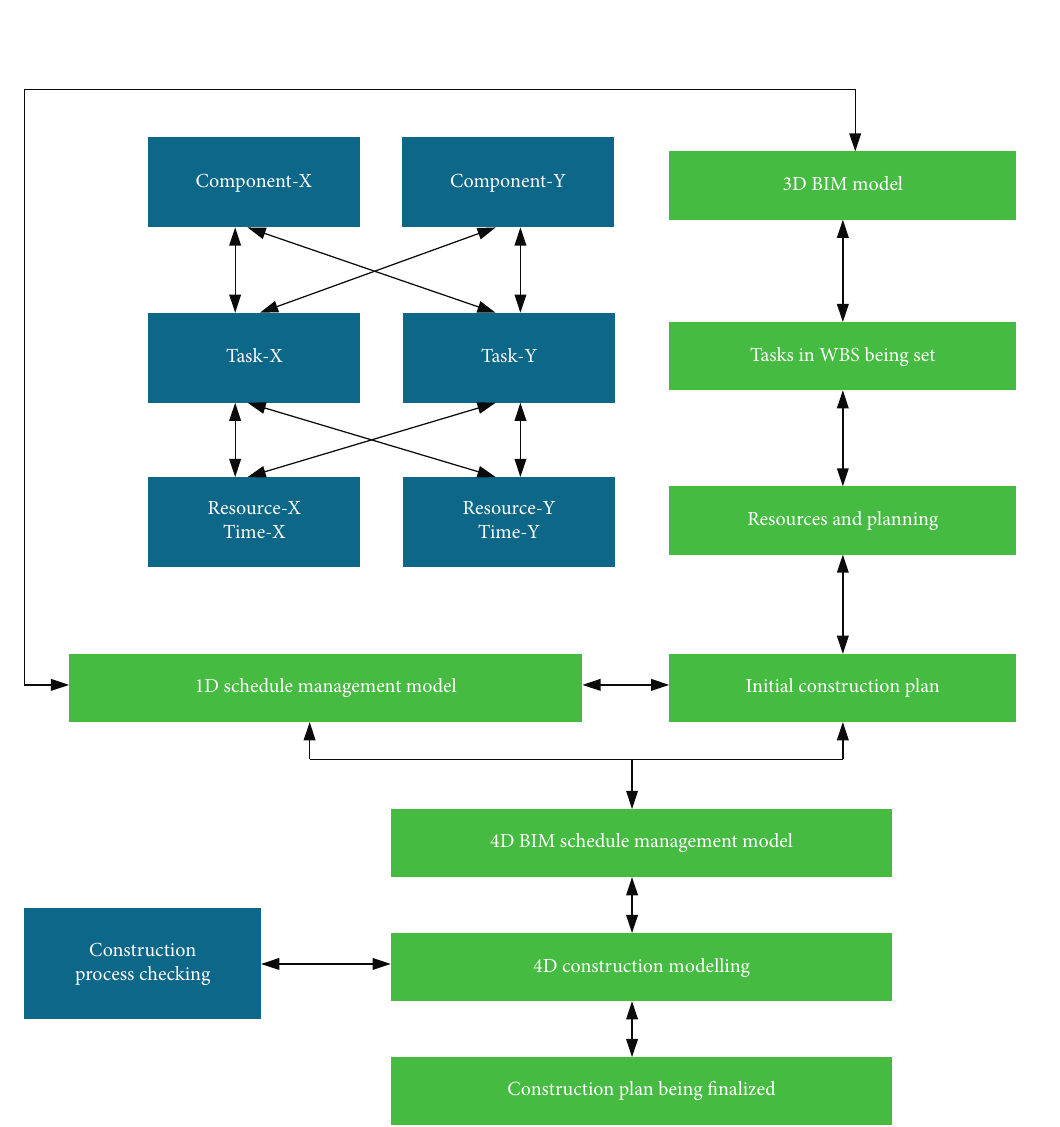
Figure 4: Flow chart of 3D BIM combined with 1D schedule management